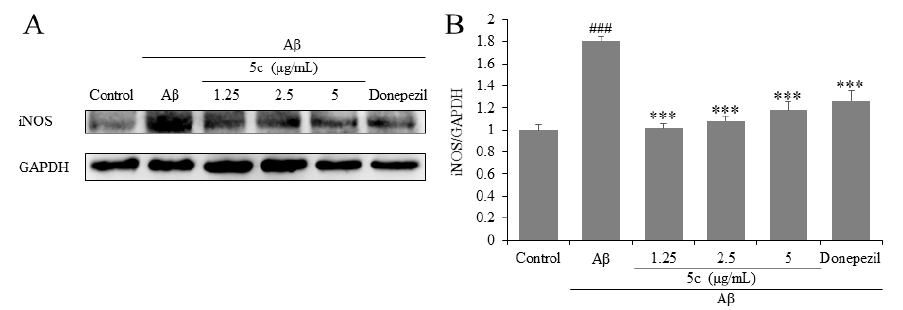
Figure 7. Effects on inducible nitric oxide synthase (iNOS) of compound 5c in PC12 cells induced by A β 25-35 . ( A ) The protein levels of iNOS were detected by Western blotting. ( B ) Quantification of iNOS expression is presented in bar graphs. ### p < 0.001 vs. control group; *** p < 0.001 vs. model group.